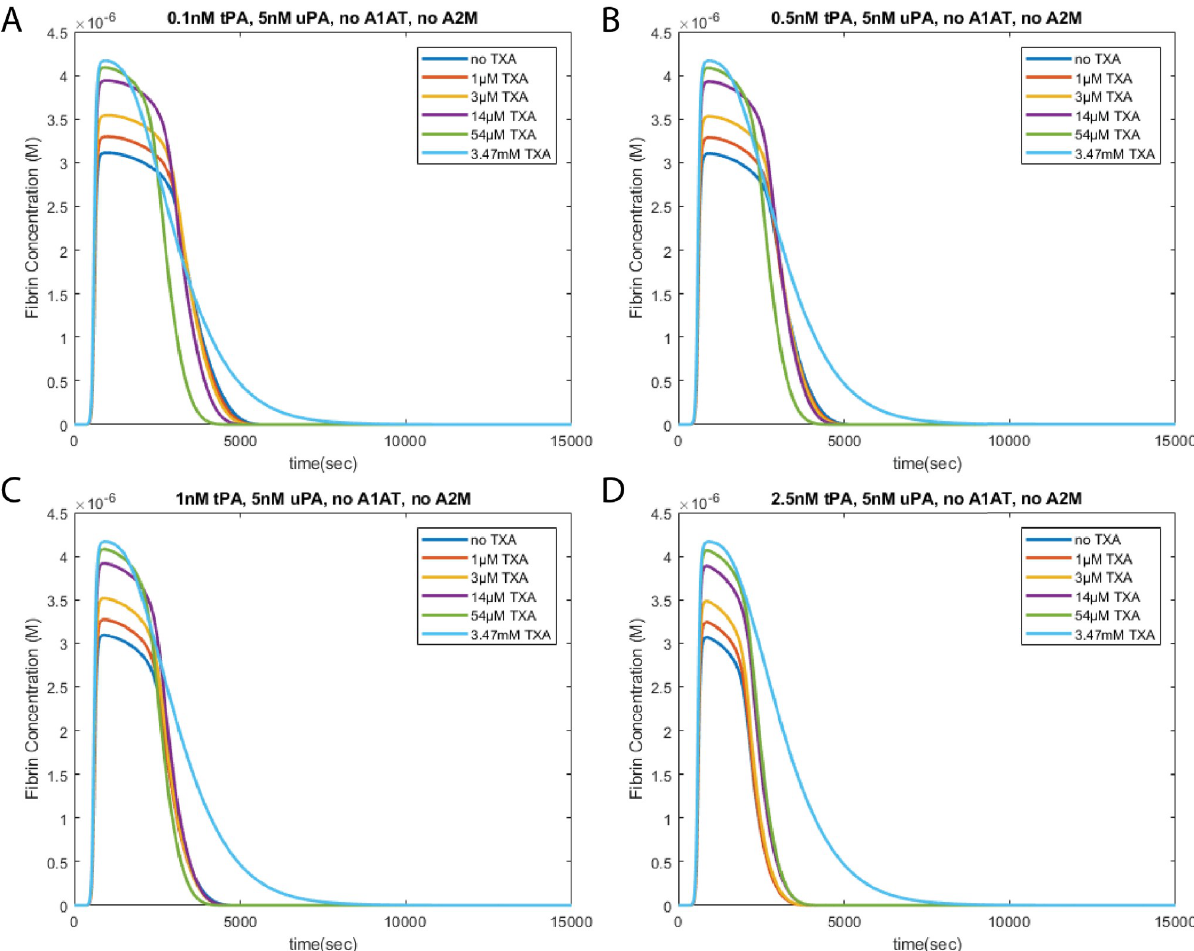
Fig 6. Effects of TXA on systems with both tPA and uPA. Modeling results show that the effect of TXA on systems with both tPA and uPA depend on the balance between the two pathways. The concentration of uPA is held constant at 5nM, as tPA is increased from 0.1nM to 2.5nM. When tPA is low compared tp uPA (A and B), TXA exhibits the pro-fibrinolytic behavior similar to Fig 5D. This behavior shifts toward anti-fibrinolytic as tPA increases. At 1nM tPA (C), the hyperfibrinolysis occurs at similar times regardless of the concentration of TXA. At 2.5nM tPA (D), TXA is anti-fibrinolytic and acts to slow down hyperfibrinolysis. These simulations are initiated with 5 pM tissue